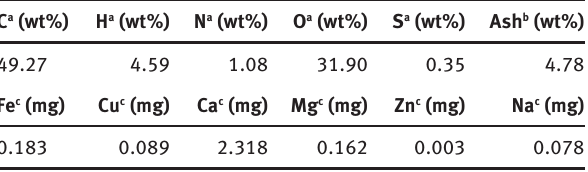
Table 1: The context of lignin used in this study.